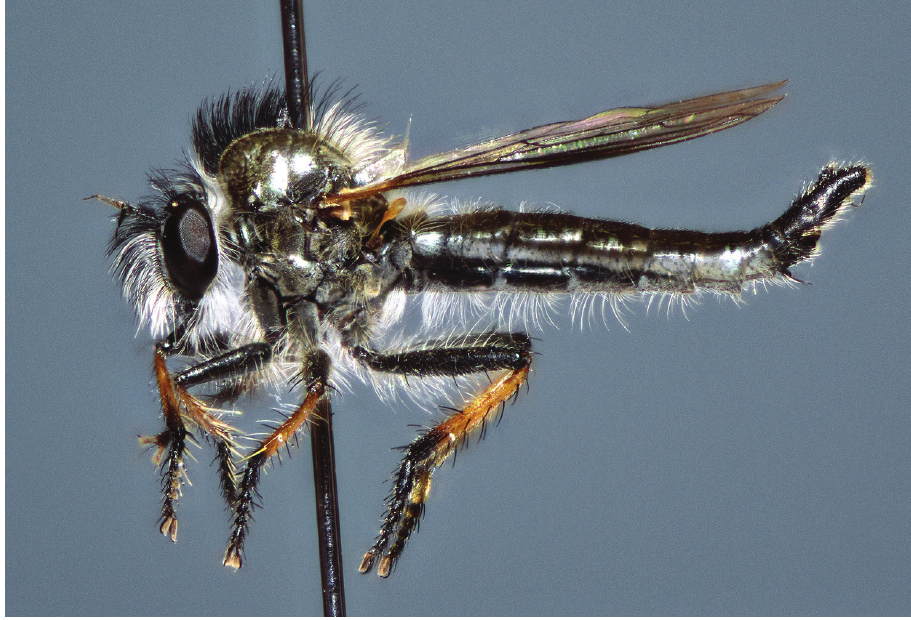
Figure 1. General appearance of a fairly typical Gibbasilus ( G. condylus sp. n.)